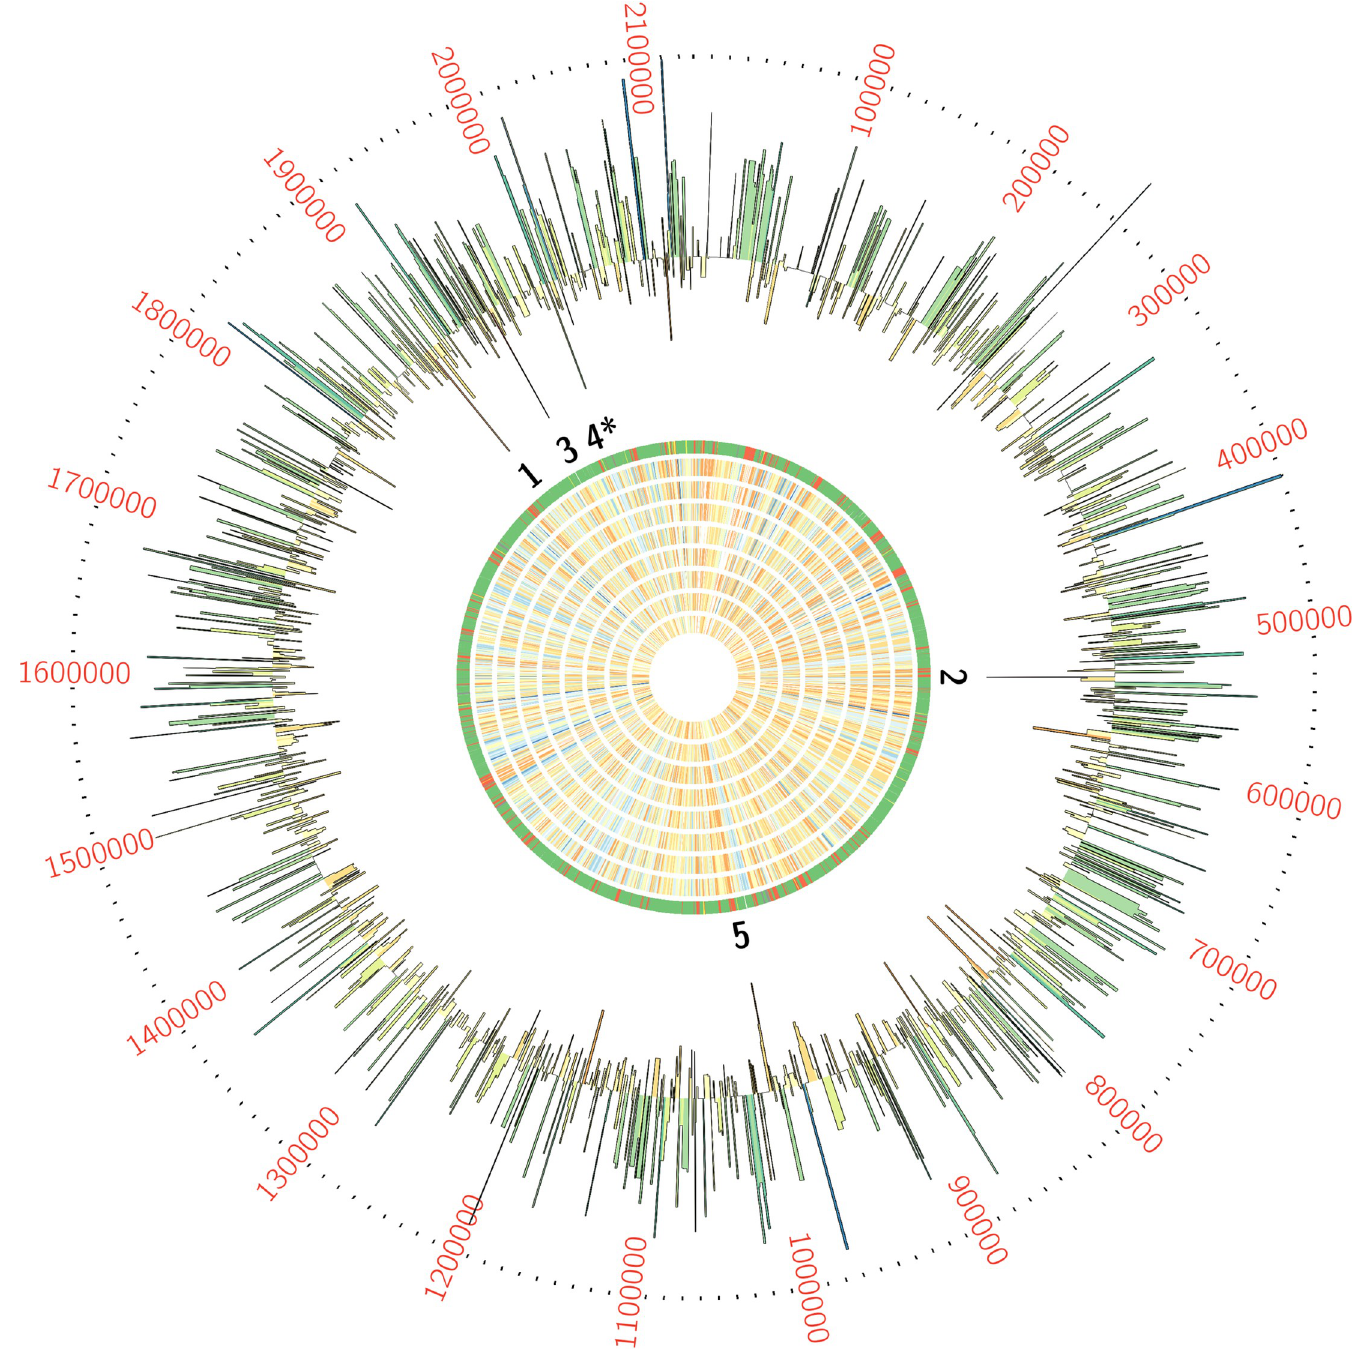
Fig 1. Tn-seq screening of GBS grown in human amniotic fluid revealed 5 conditionally essential genes. GBS transposon library in a background of strain A909 was grown in eight human amniotic fluid samples from three individuals (see main text), then subjected to Tn-seq analysis. Each ring of the Circos plot shows a different representation of the A909 circular chromosome. From the center of the plot, rings 1–8 show transposon insertion density detected in the eight amniotic fluid outgrowth samples (lowest detection: red; highest detection: blue). Ring 9 shows essential genes (red), nonessential genes (green), intermediate genes (yellow), and those for which baseline fitness cannot be determined (white; see reference [41]). The outermost ring shows log 2 fold-change values for each gene in amniotic fluid outgrowth as determined by ESSENTIALS. Genes with inward-pointing peaks had fewer than expected transposon insertions. Outward-pointing peaks had more than expected transposon insertions. The peaks are color coded for statistical significance (low adjusted p value: red; high adjusted p value: green). The five labeled peaks are described in the text and are listed in Table 1 . Peak 4 is the GntR-class transcription factor, mrvR .